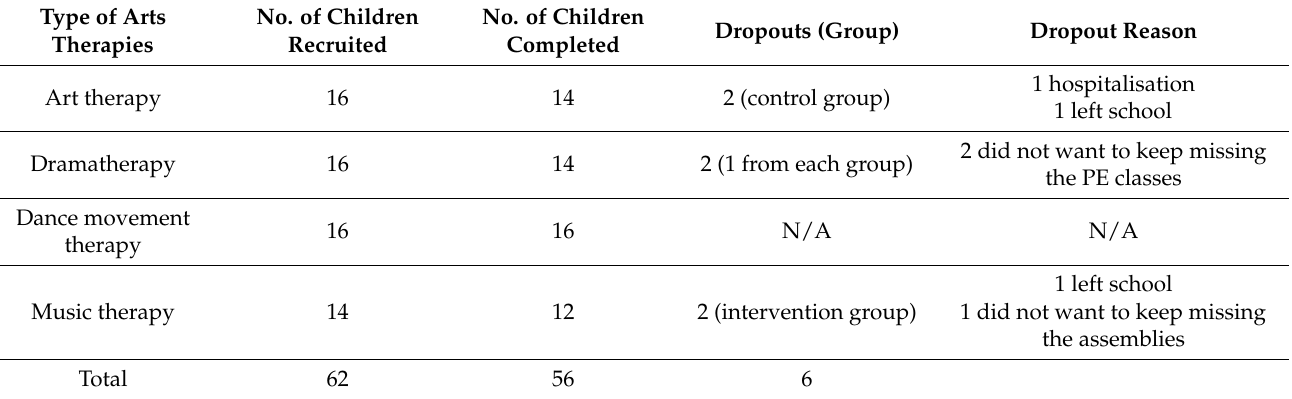
Table 1. The recruitment and dropout rates (with reasons) for each type of arts